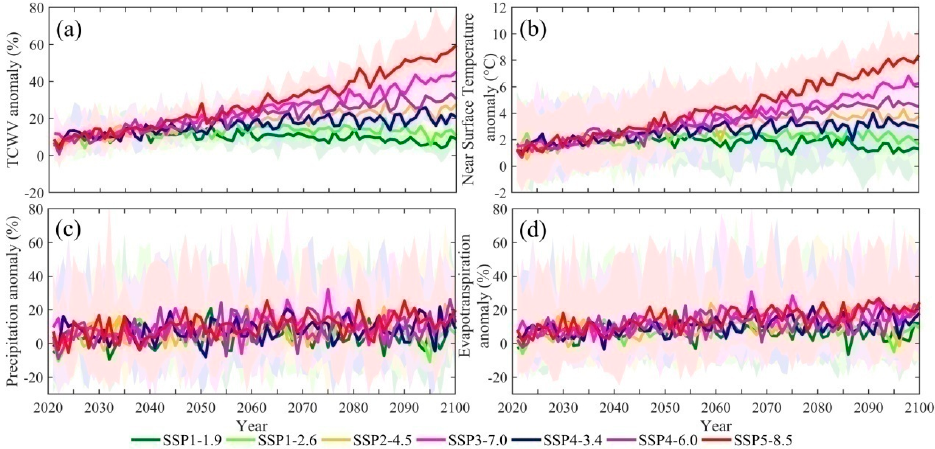
Figure 5. Anomaly time series of annual ( a ) TCWV, ( b ) near-surface temperature (Ts), ( c ) precipitation, and ( d ) evapotranspiration of Multi Model Ensemble (MME) mean values (relative to the 1986–2005 baseline period). The color shadows reflect the uncertainty range of climate models. The shading indicates the uncertainty range of simulation results by 4 CMIP6 models.